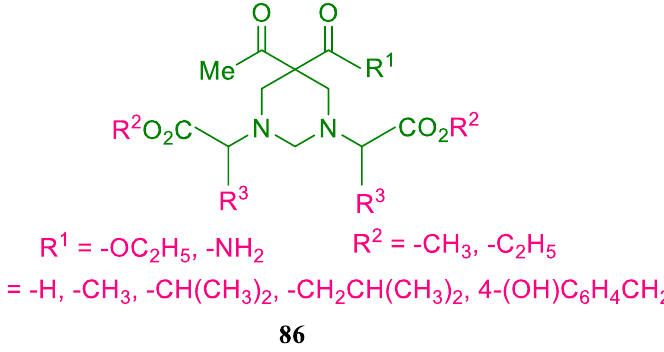
Figure 70. N- substituted α -amino acids analogues consisting hexahydropyrimidine moiety. Figure 70. N-substituted α -amino acids analogues consisting hexahydropyrimidine moiety.